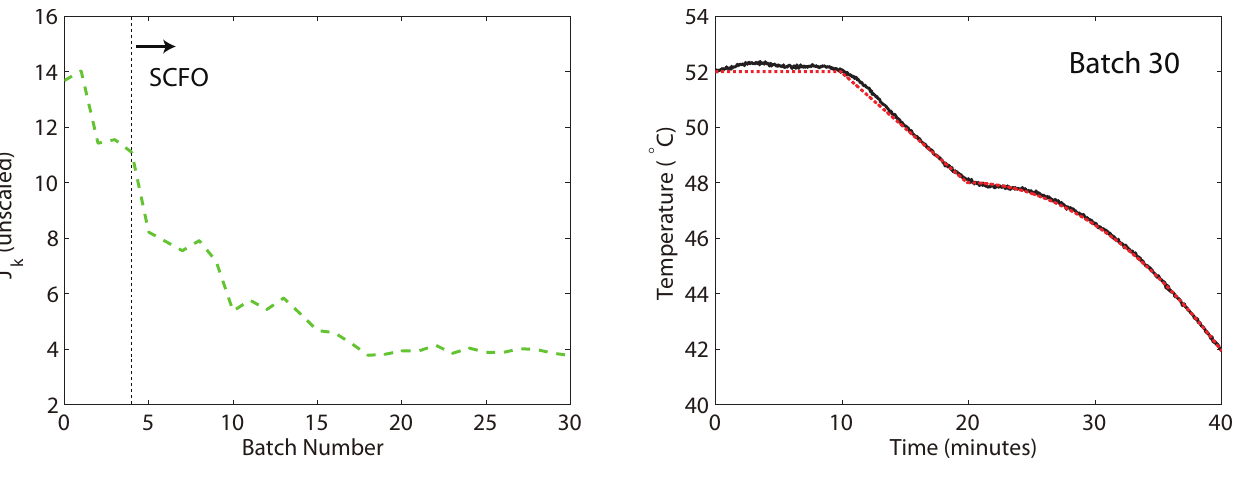
Figure 7. The measured performance metric for the solution of Problem (17), together with the tracking obtained for the final